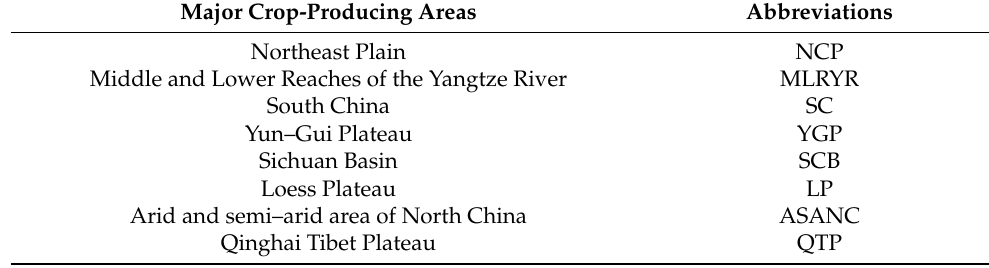
Table 1. Abbreviation of study area sub-regions.